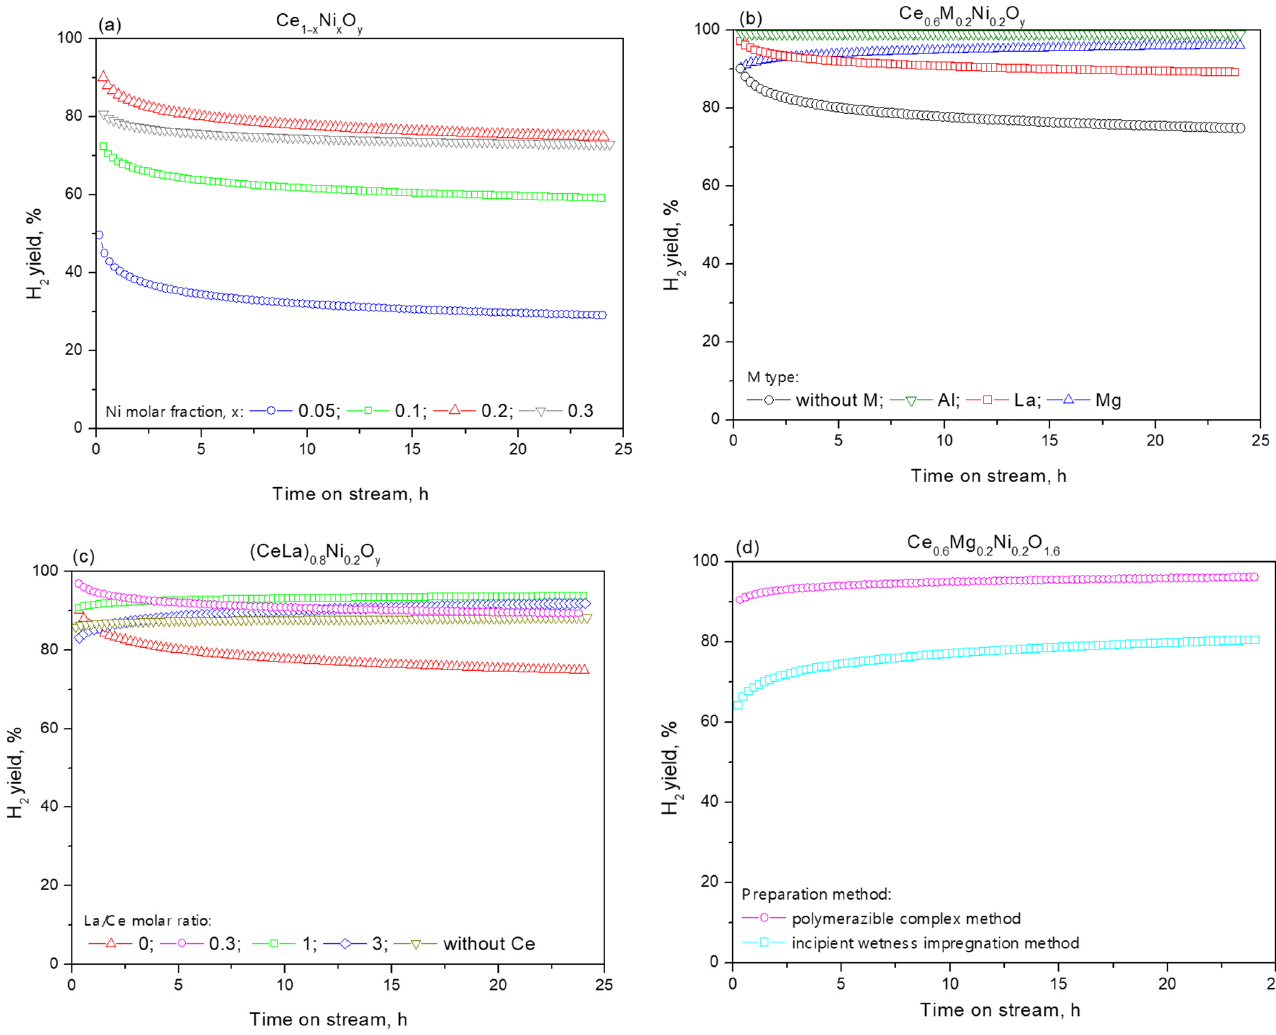
is significantly lower than the specific rate of H 2 formation: 6.8 × 10 − 5 mole C /(mole Ni · min) * relative decrease in hydrogen yield after 24 h of time on stream. vs. 5.0 mole H2 /(mole Ni · min).